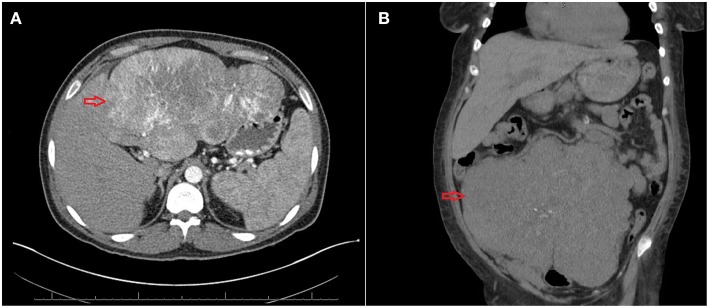
(A) Computed tomography (CT) of the abdomen showing a large mass of 20 cm size (red arrow). (B) CT of the abdomen showing a large tumor of 24 cm* 18 cm*12 cm (red arrow).